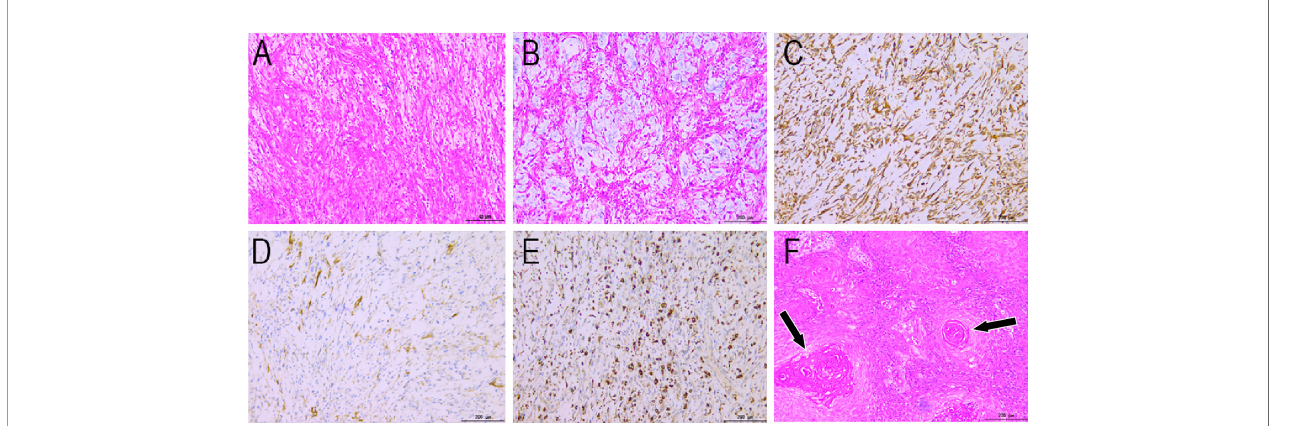
FIGURE 3 | Histopathological fi ndings (HE staining: A , ×40; B , ×200) show fusiform tumor cells, curving vessels, and myxoid alterations in the stroma. Immunohistochemical staining showing vimentin (C) , SMA (D) , and CD68 (E) positivity. (F) Histopathological view of the right inguinal lymphadenopathy. HE staining shows irregular squamous cells and horn strains (arrows). HE, hematoxylin and eosin.